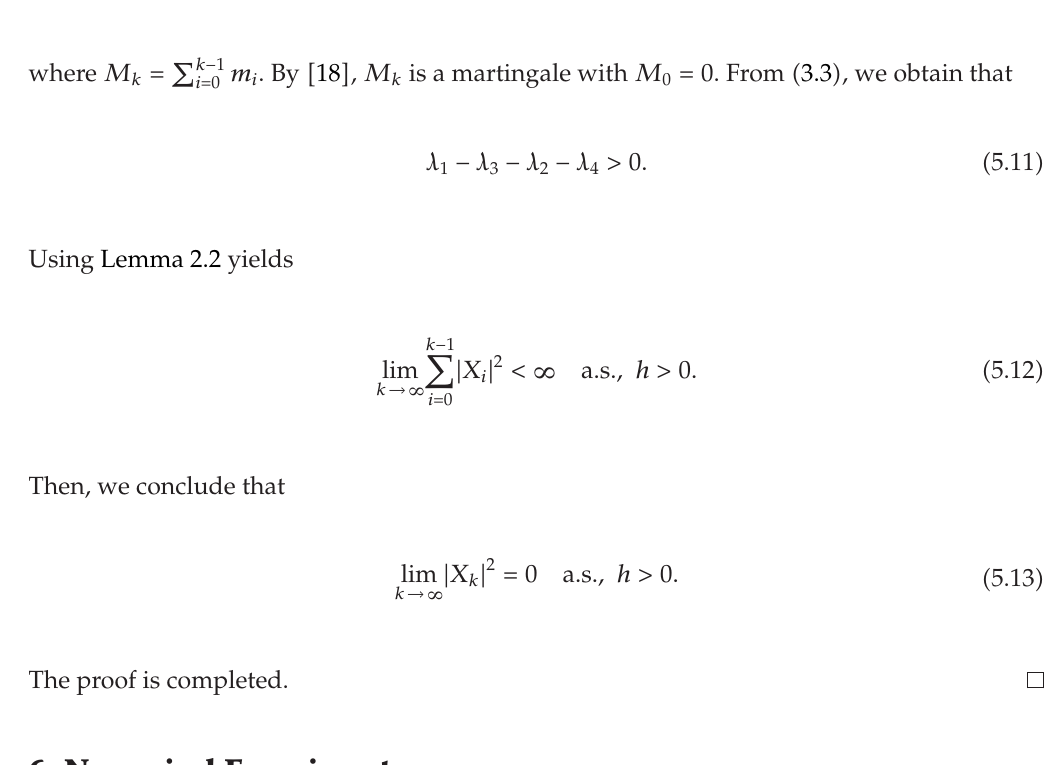
(cid:17) k − 1 where M k (cid:7) m i . By (cid:5) 18 (cid:6) , M k is a martingale with M 0 (cid:7) 0. From (cid:3) 3.3 (cid:4) , we obtain that i (cid:7) 0